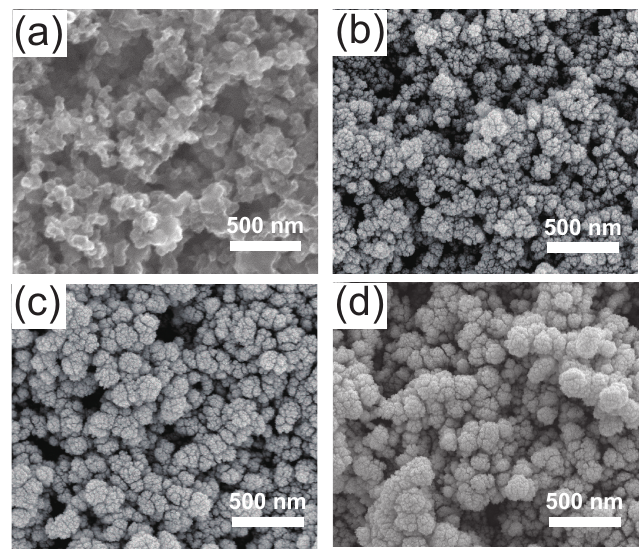
Figure 2. SEM images of Pt particles deposited by PLD at 107-Pa Ar pressure on a GDL with various Pt loadings: ( a ) GDL only; ( b ) 75 µ g · cm − 2 ; ( c ) 100 µ g · cm − 2 ; and ( d ) 125 µ g · cm − 2 .